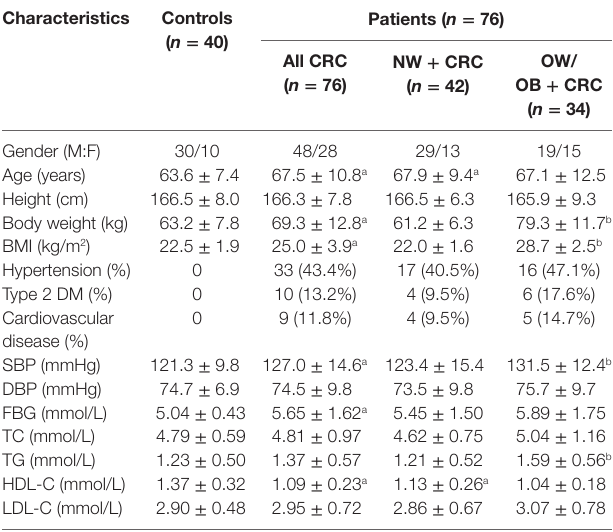
TaBle 1 | General characteristics of subjects in NW + CRC, OW/OB + CRC, and control groups.